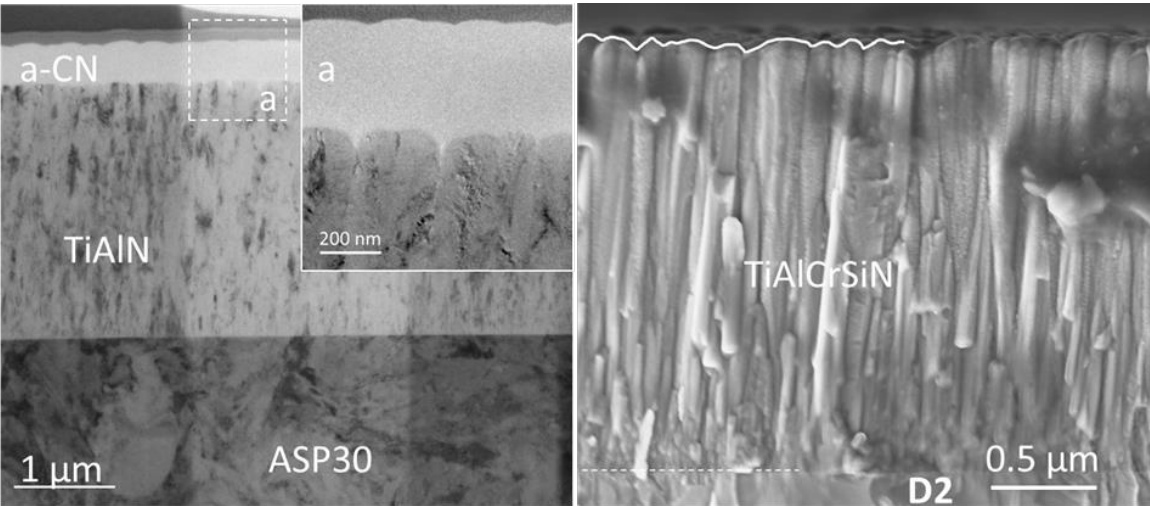
Figure 19. TEM cross-sectional image of a-CN/TiAlN and fracture cross-section SEM image of a TiAlCrSiN hard coating show how columnar microstructure changes the surface topography. It is evident that the surface roughness of the coating has its origin in the columnar microstructure. Both coatings were sputter deposited in the CC7 deposition system on tool steel substrates (ASP30, D2).